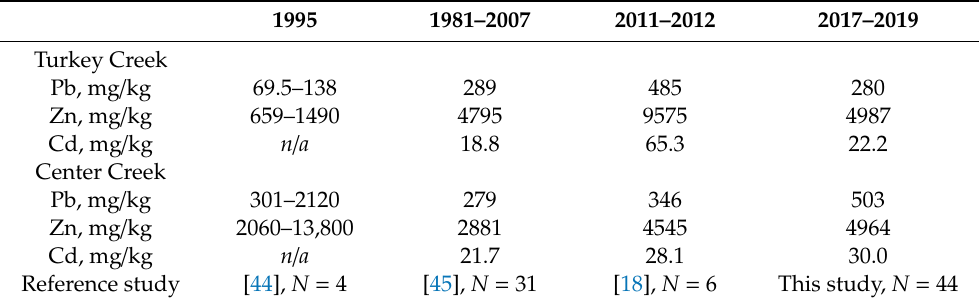
Table 3. Average (or range of values) of metal concentrations in stream sediments (depth 0–1 ft) reported for Turkey Creek and Center Creek, Missouri. N = No. of